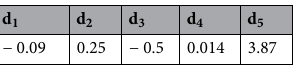
Table 4. JC Damage model parameters for Ti6Al4V.